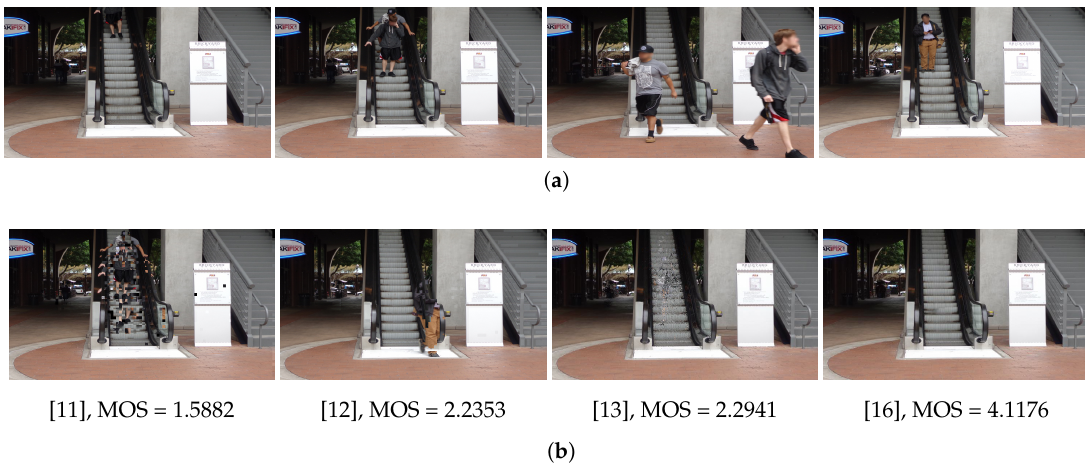
Figure 4. Example input sequence and recovered background images with corresponding MOS scores from the ReBaQ dataset. ( a ) Four out of eight input images from the input sequence “Escalator”; ( b ) Background images reconstructed by different algorithms and corresponding MOS